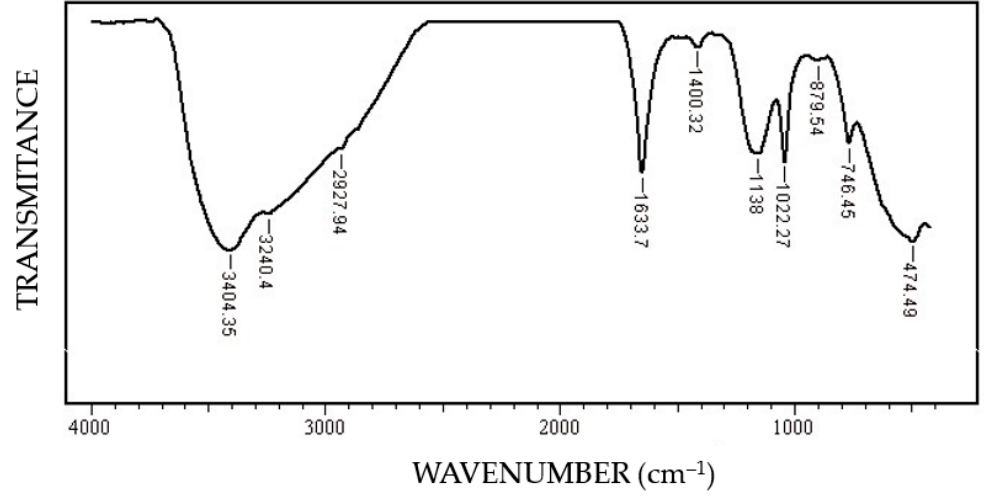
Figure 10. FT-IR spectrum of the corrosion product on the surface of the C45 sample maintained for 85 days in BSW.